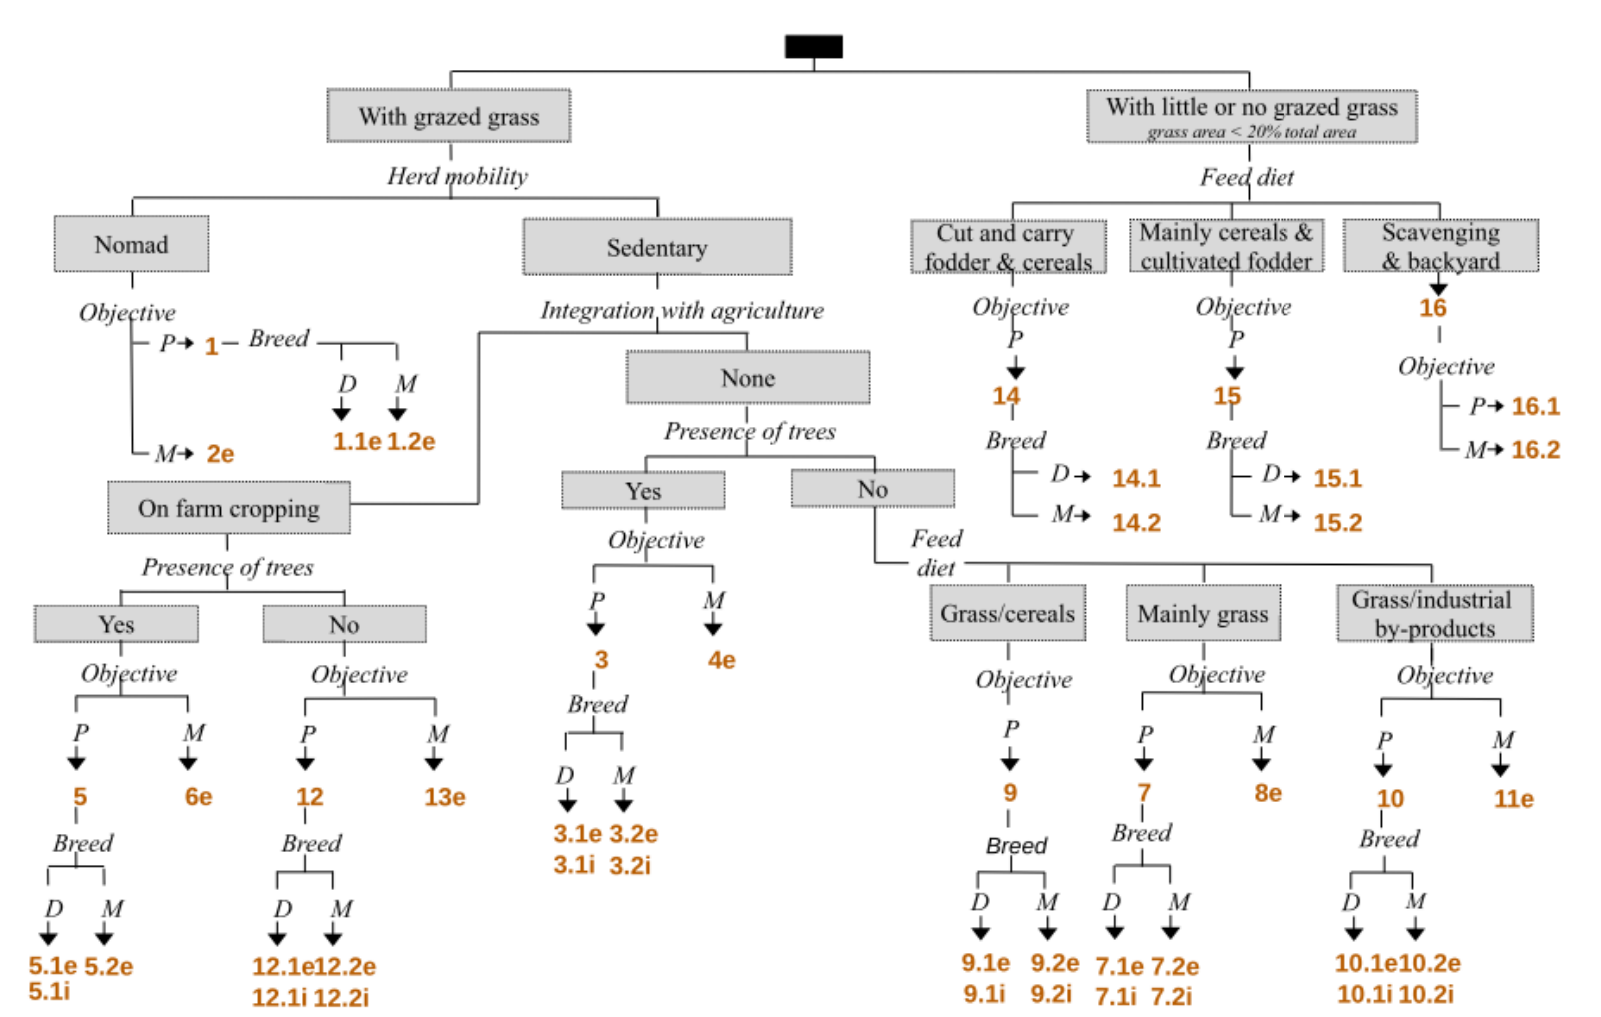
Figure 2. Decision tree for the construction of cattle MTs typology based on criteria (D: dairy breed, M: meat breed, P: production, M: multi-function, i: intensive pasture management, e: extensive pasture management).